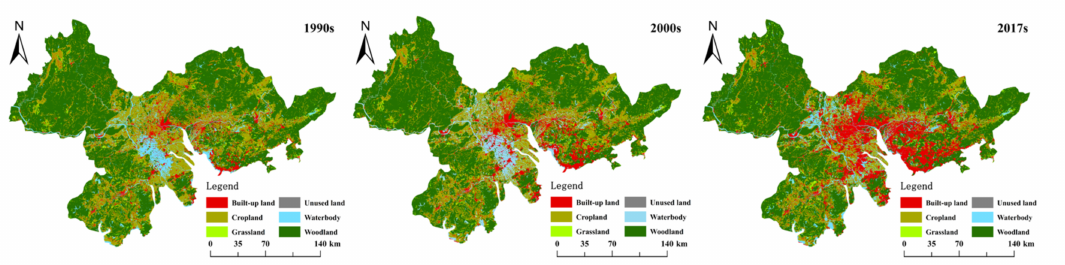
Figure 2. Spatial distribution of land